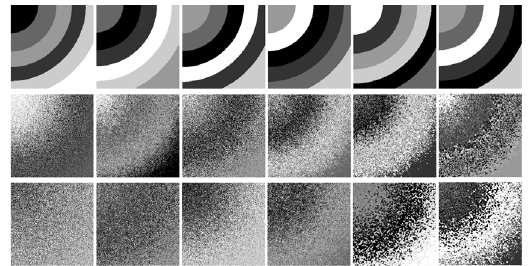
Fig. 2. Visualized clustering results on images from Fig. 2: original images(first row), images corrupted by noise of SNR =15 (second row) and images corrupted by noise of SNR =10 (third row), respectively by: FCM (first column), sFCM (second column), gFCM (third column), bFCM (fourth column), wFCM (fifth column) and dwFCM (sixth column)